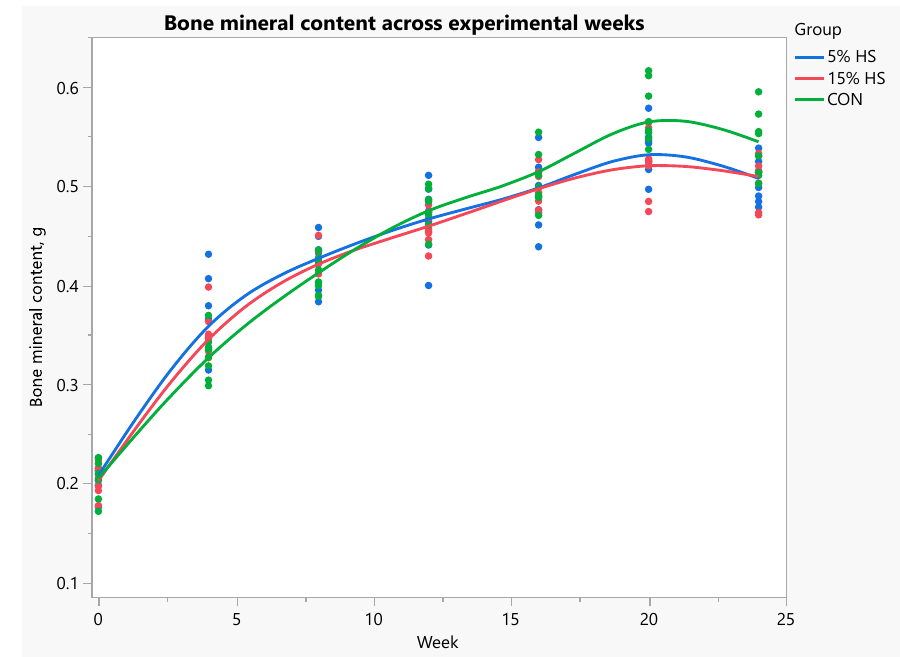
Figure 10. Bone mineral content (g) across experimental weeks. Measurements obtained by dual- energy X-ray absorptiometry in live mice. N = 8 per group. Each dot represents an individual mouse; colors represent the experimental diet group. Mixed models with repeated measures showed no significant differences among groups ( p = 0.85). Effect of week, p <